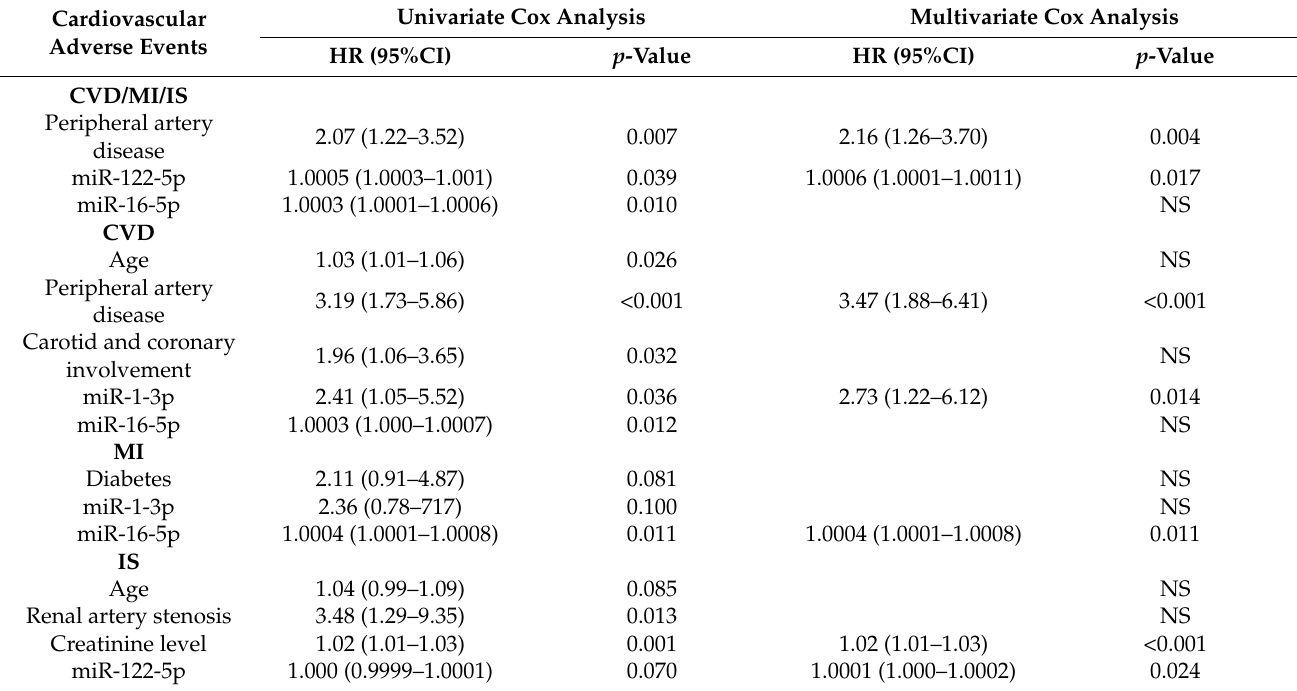
Table 2. Univariate and multivariate Cox proportional hazard analyses for predictors of cardiovascular events during